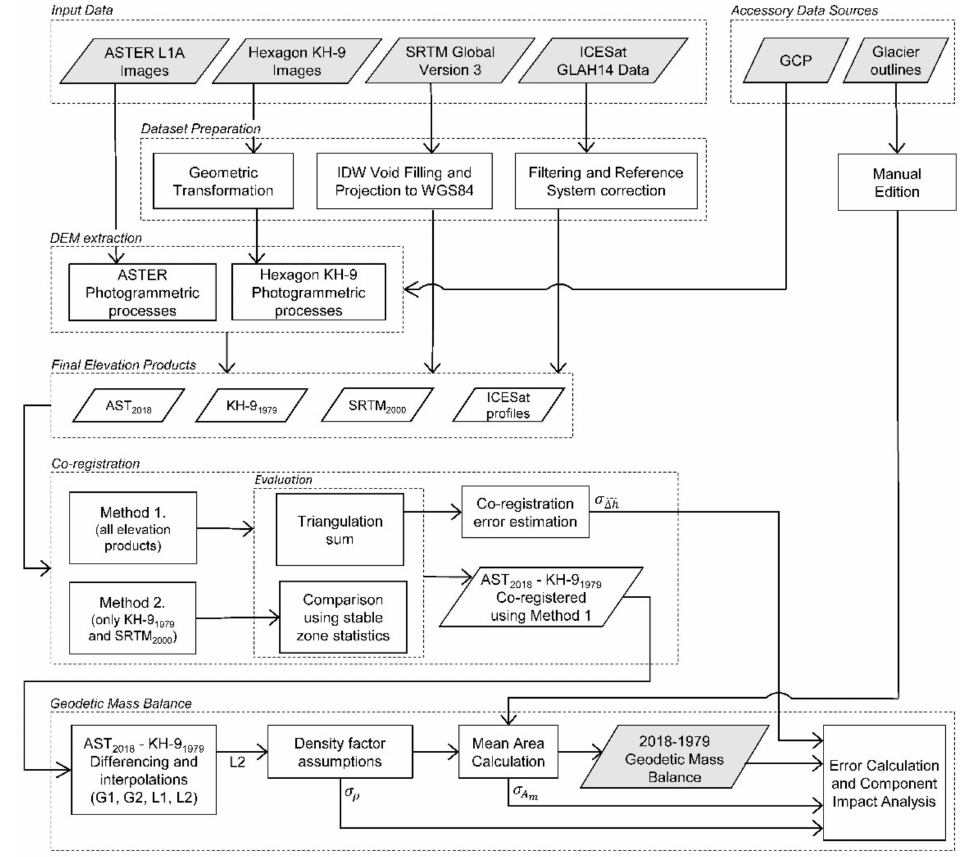
Figure 2. Methods